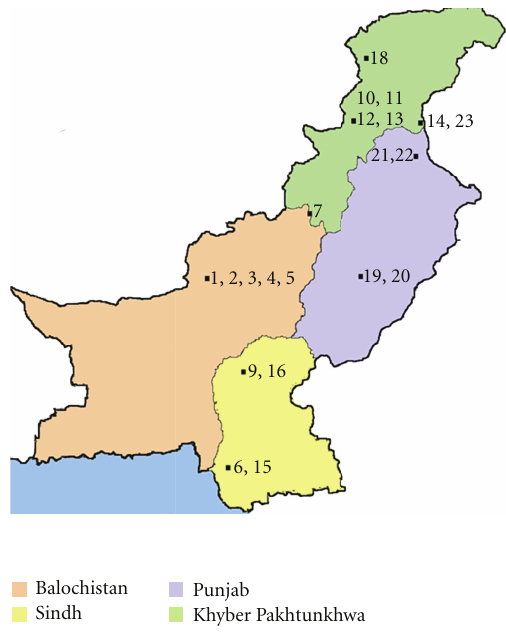
Figure 3: Distribution of CL in the 4 provinces of Pakistan (numbers represent the studies as noted in the references). As noted in the map as well, the province of Balochistan followed by Khyber Pakhtunkhwa appears to have taken a major toll. Most of the cities and hospitals where the disease has been identified serve as major tertiary care referral centers for the rest of the province. The exact estimates in adjoining cities and rural areas are underestimated and not well